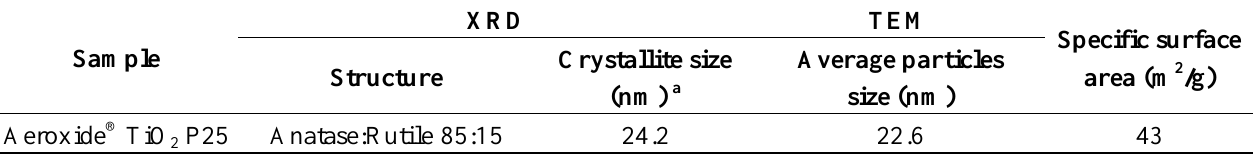
Aeroxide ® P25 determined by XRD analysis. 2